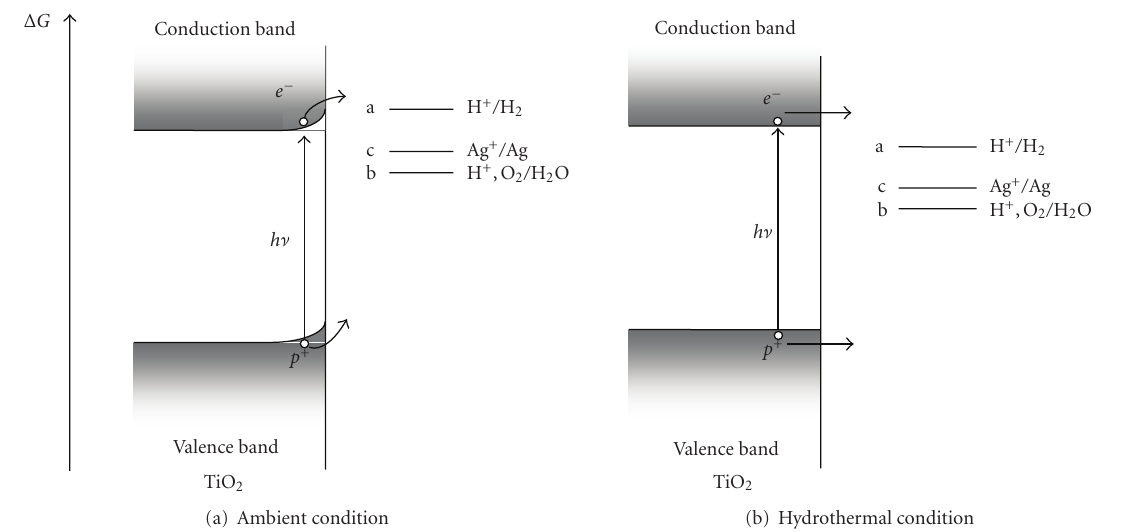
Figure 6: Schematic energy-level diagram showing photoreduction and photooxidation at the TiO 2 -aqueous solution interface. Symbols h ν denote the photon energy of near-UV light, e − and p + the conduction-band electron and positive hole, respectively. a; H + /H 2 , b; H + , O 2 /H 2 O, and c; Ag + /Ag: electronic redox levels. (a) Aqueous solution in ambient conditions; T = 25 ◦ C, P = 0.1 MPa. (b) Aqueous solution in hydrothermal conditions; T = 100–400 ◦ C, P =